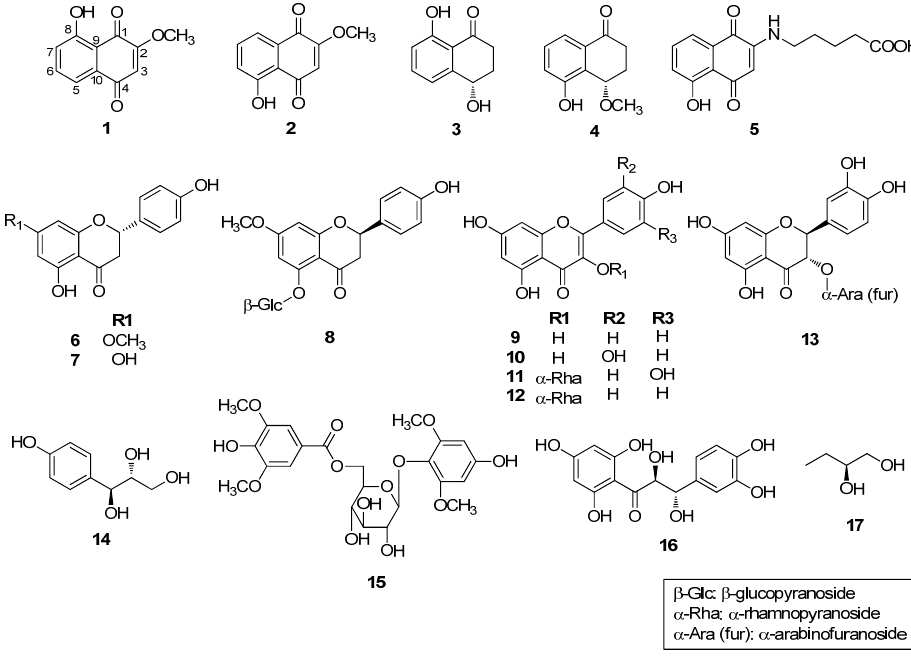
Figure 1. Chemical structures of the isolates 1 – 17 from the bark of J. sinensis .